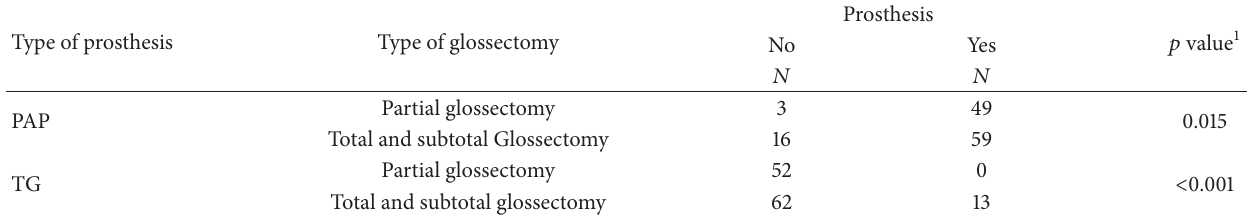
Table 3: Type of glossectomy and palatal augmentation prosthesis (PAP) or tongue prosthesis (TP). Type of prosthesis